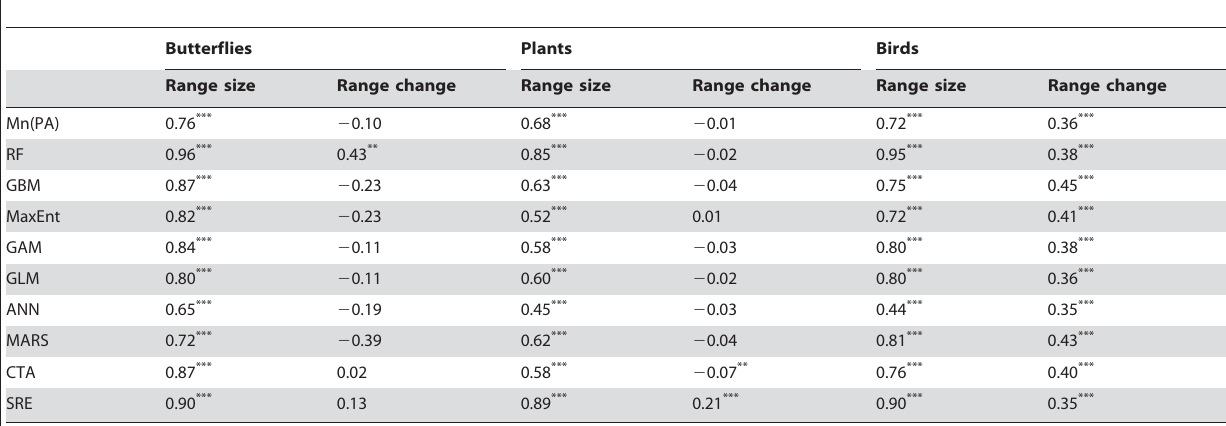
Table 3. Correlation coefficients of observed versus predicted range size and range change for model forecasts.